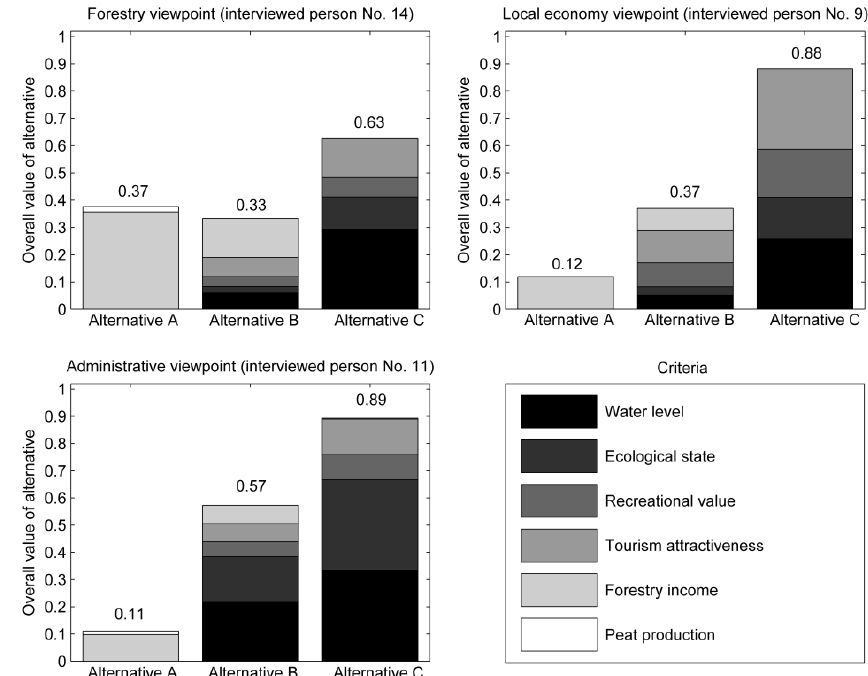
Fig. 7. Overall values of the forestry, local economy and administrative perspectives. Figure 7. Overall values of the forestry, local economy and administrative the stakeholders. There was agreement that this was the most perspectives. significant benefit of the MCDA